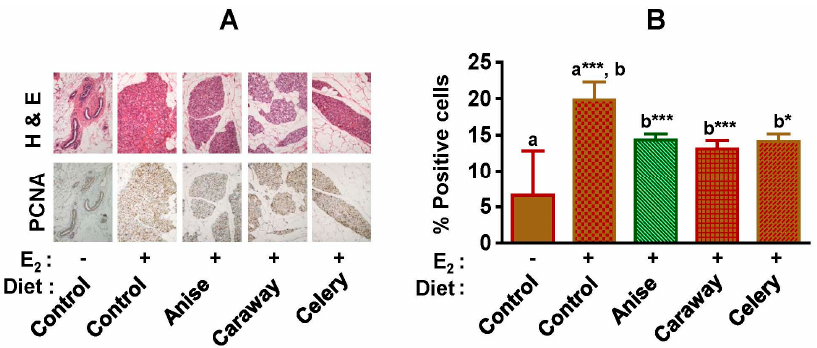
Figure 2. Effect of dietary Apiaceae spice intervention on the mammary cell proliferation in the absence and presence of 17 β -estradiol (E2) treatment. ( A ) Representative photomicrographs (20× magnification) of normal and hyperplastic mammary tissue following immuno-histochemical staining for proliferating cell nuclear antigen (PCNA); ( B ) Percentage (average ± SD) of deeply-stained cells for PCNA in mammary tissues ( n = 5). Symbols (– and +) denotes the absence and presence of E2, respectively. Alphabets (a and b) followed by asterisk shows statistical differences at * p < 0.05, *** p < 0.001.